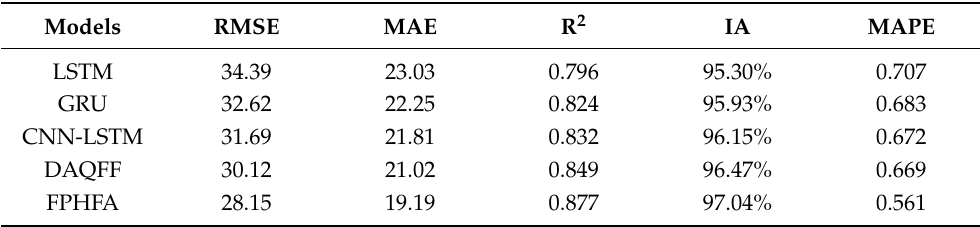
Table 2. The model performance evaluation indicators of models in short-term PM 2.5 concentration